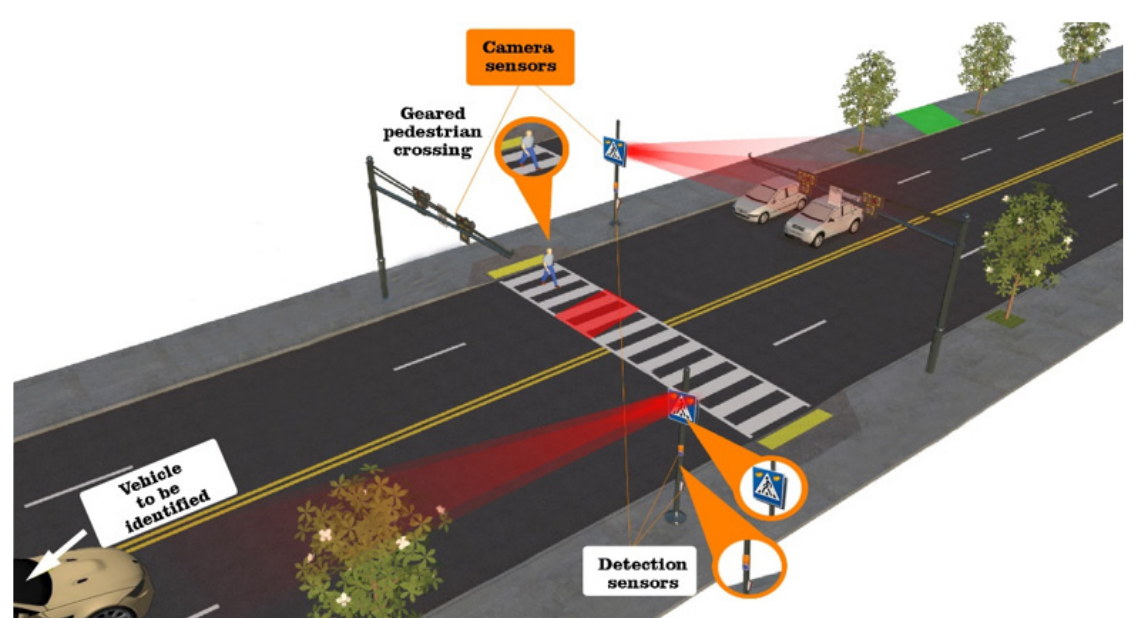
Figure 3. Representative diagram of a traffic monitoring system based on cameras.